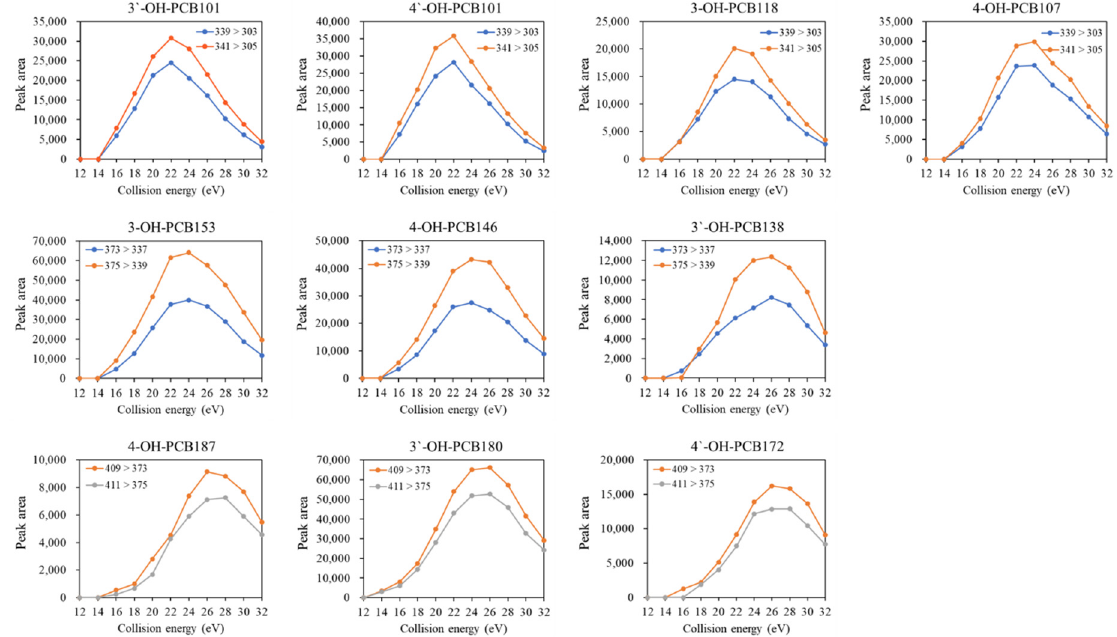
Figure 1. Effect of collision energy on the peak area of selected transitions of OH-PCB congeners.